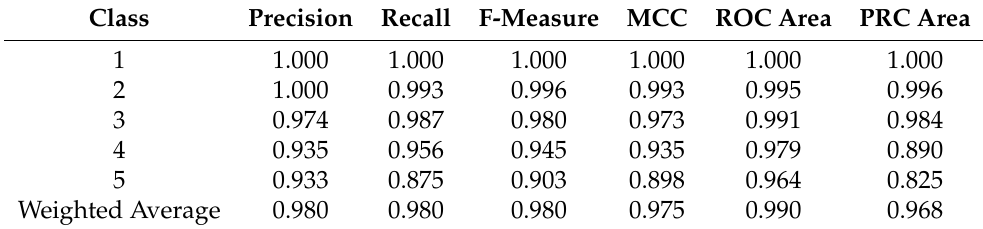
Table 18. CDT accuracy details.